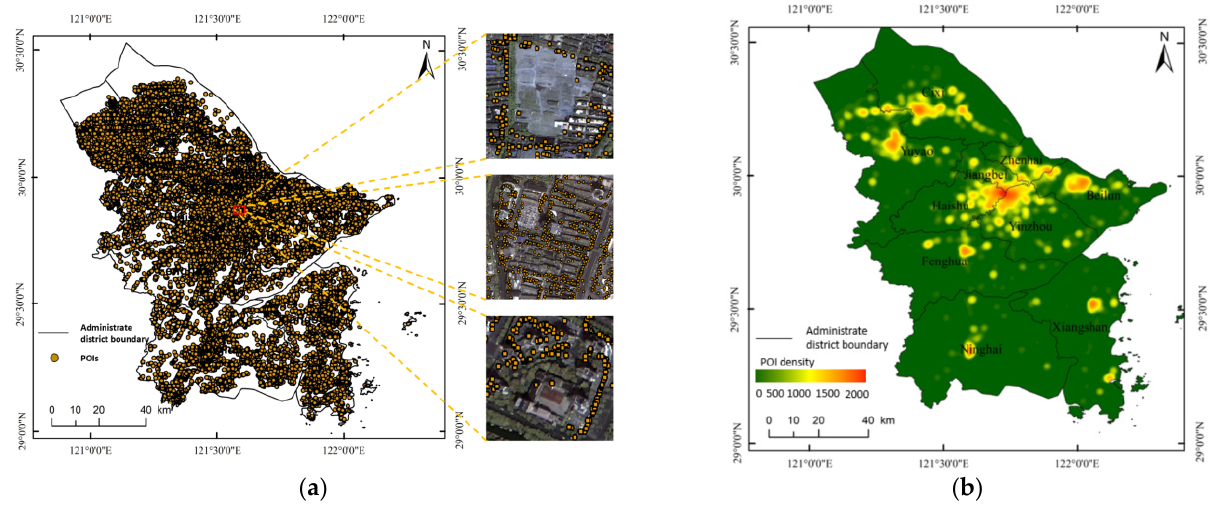
Figure 2. Point of interest (POI) data for Ningbo in June 2019. ( a ) Spatial distribution of POIs. ( b ) Density of POIs counted in segmentation units.